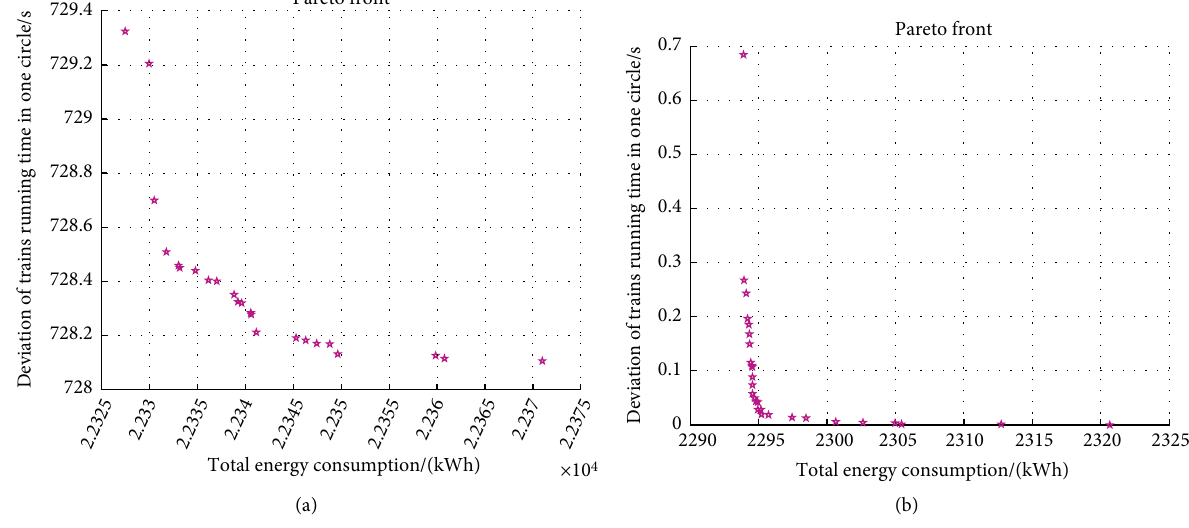
Figure 16 : The Pareto front under and OIC = 0.3. (a) The Pareto solutions of the OEST. (b) The Pareto solutions of the 𝐺 = 150